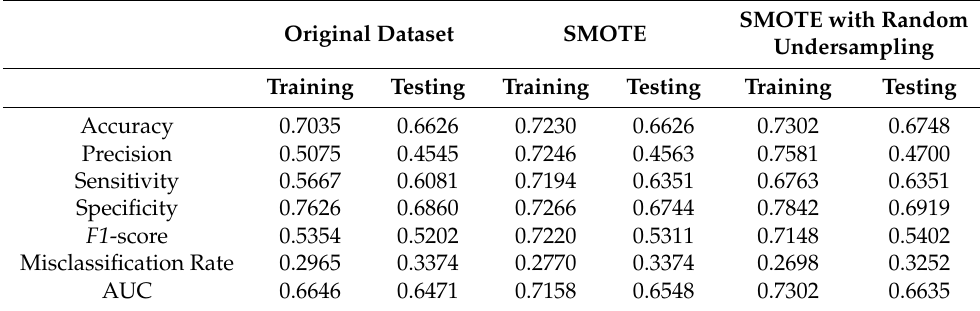
Table 5. Effects of using SMOTE and SMOTE with random sampling with a Logistic Regression model.